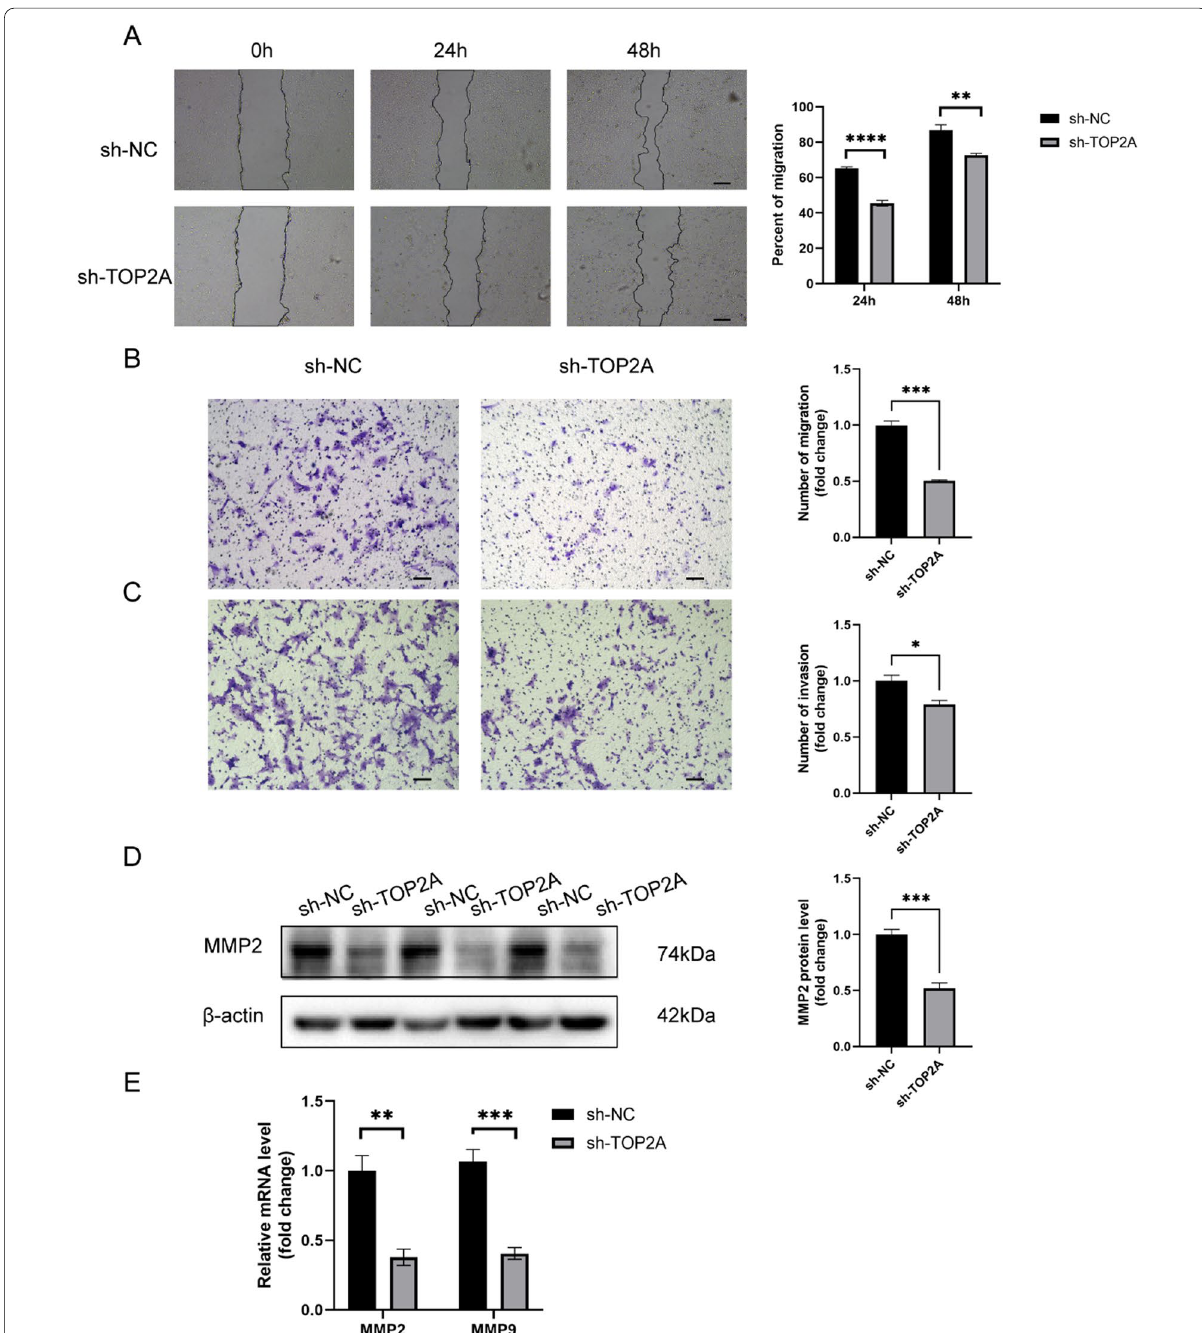
Fig. 4 TOP2A promotes migration and invasion of trophoblast cells. A The effects of TOP2A knockdown on the migration rate of JEG-3 cells was determined using a wound healing assay. B Transwell assay was used to assess migration of trophoblasts. C Invasion of trophoblasts was assessed by transwell assay. D The effect of TOP2A on the expression of invasion-related protein metalloproteinase-2 (MMP-2) was assessed. E qRT-PCR was employed to determine the effect of TOP2A knockdown on the mRNA levels of MMP2 and MMP9 . * P < 0.05, ** P < 0.01, *** P < 0.001, **** P < 0.0001. ns, no statistical difference. Scale bar: 100